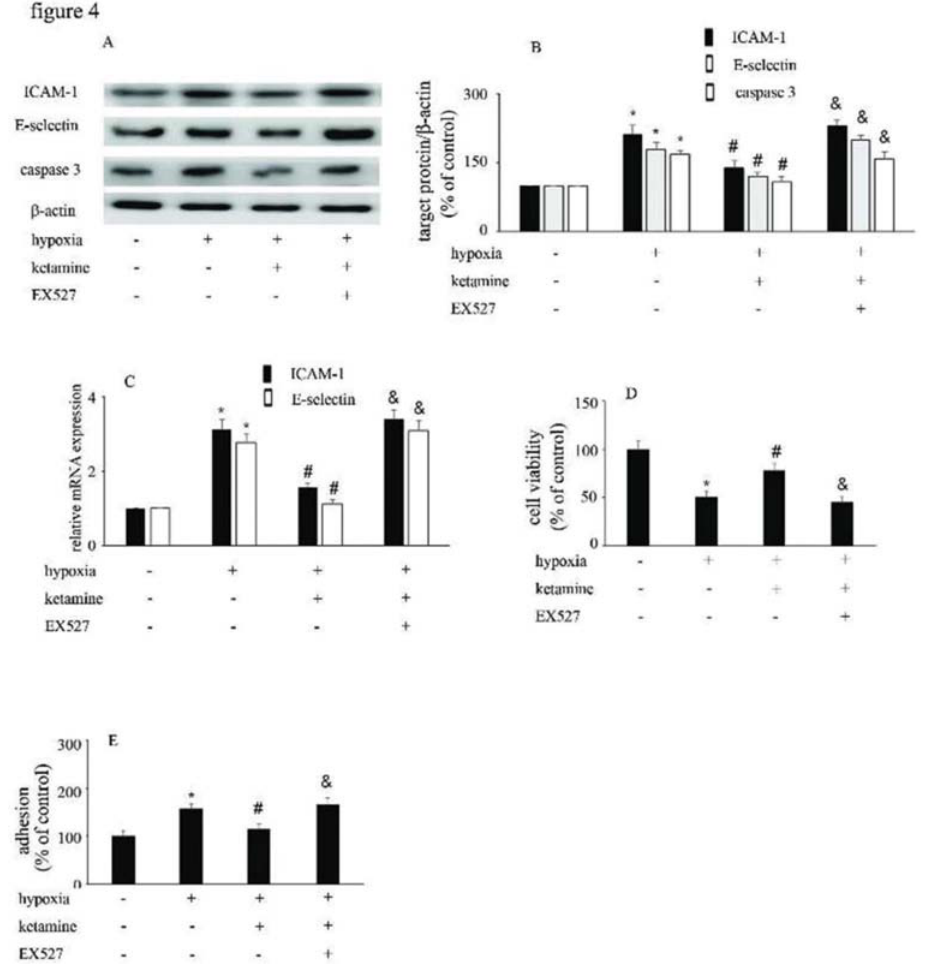
Figure 4 - The viability of HUVECs and the HUVEC/monocyte adhesion ability were modified by hypoxia, ketamine, and EX527. (A) Equal amounts of proteins were separated by SDS-PAGE and immunoblotted with antibodies against ICAM-1, E-selectin, and caspase-3. (B) The ratio of the protein expression of each specific protein (ICAM-1, E-selectin, and caspase-3) to the expression of b -actin. (C) Ketamine reversed the hypoxia-mediated decrease of HUVEC viability, while the effect of ketamine was counteracted by EX527. (D) Ketamine reduced the hypoxia-induced increase in monocyte/endothelial cell adhesion, while this effect of ketamine was counteracted by EX527. (* p o 0.05 versus the control group, # p o 0.05 versus the hypoxia group, & p o 0.05 versus the ketamine group,